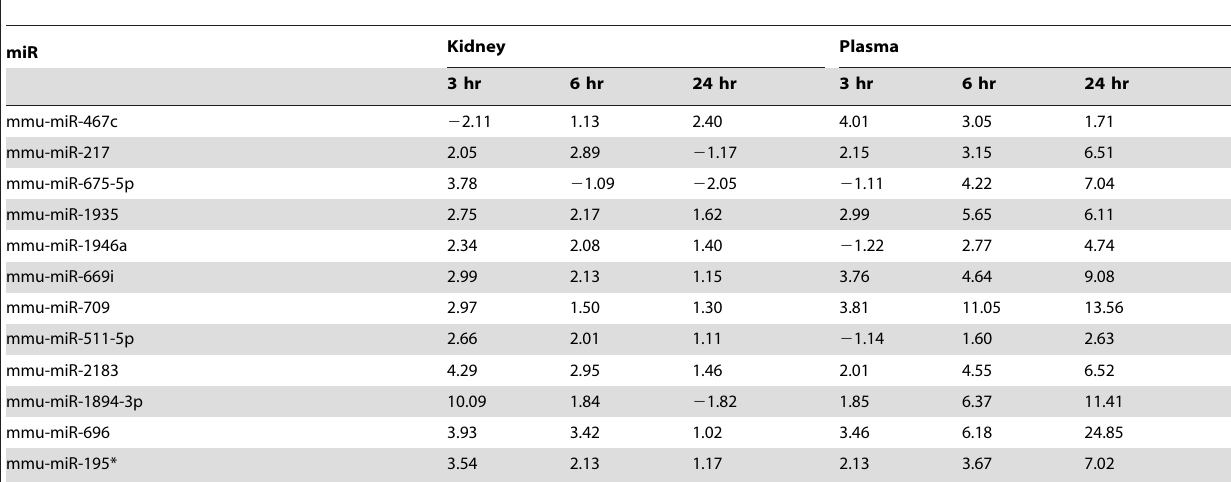
Table 1. MicroRNAs discordantly modulated in kidneys and plasma (pooled sample results).